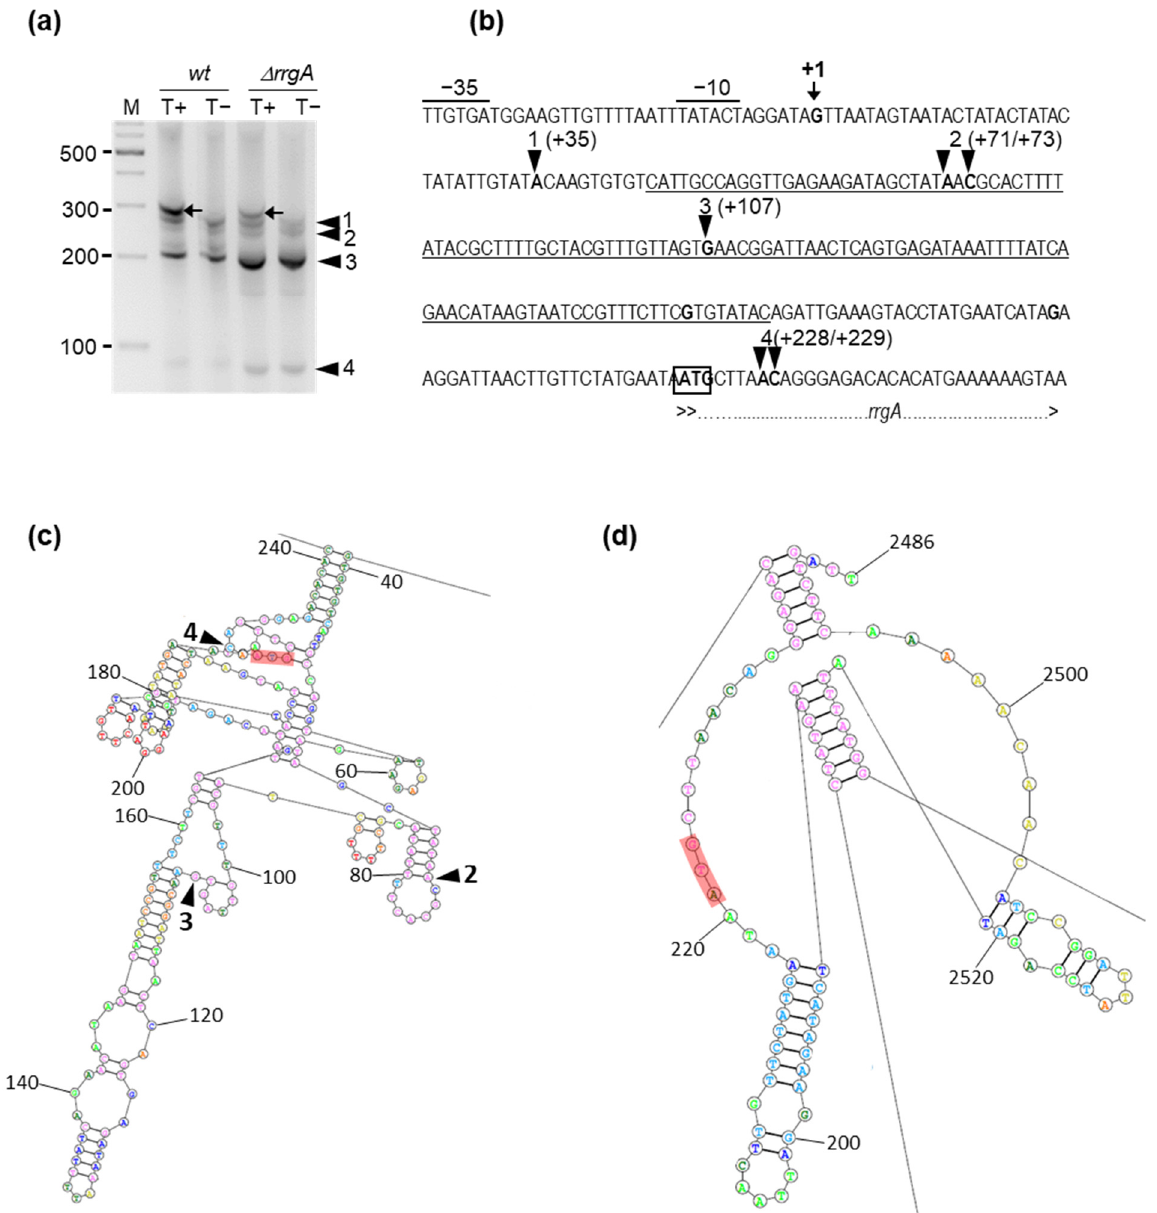
Figure 3. srn135 is generated upon processing of the rrgA transcript. ( a ) 5 ′ RACE mapping of the srn135 small RNA and the rrgA transcript. Reverse transcription was carried out on 7 μ g of total RNA extracted from the wild type and Δ rrgA mutant strains as described in Materials and Methods. PCR signals upon treatment with TAP (T+) or without treatment (T-) were separated in a 4% agarose gel. The RACE product that was present only in TAP-treated samples (black arrow) corresponded to the 5´-end of the full-length transcript, whereas RACE products 1, 2, 3, and 4 (arrowheads) present in TAP-treated and non-treated samples are likely to be processing fragments. ( b ) Sequence of the region comprising the 5 ′ UTR of rrgA mRNA and the beginning of the ORF. Transcriptional start site (highlighted with a black arrow) was identified as a G located 7 nt downstream of the − 10 box. The nucleotides corresponding to the 5 ′ -end of RACE products 1, 2, 3, and 4 (arrowheads), are highlighted in bold. The ATG of rrgA is delimited by an empty box and the beginning of the ORF is indicated as a dashed line. The putative − 35 and − 10 of the promoter are indicated and the nucleotide sequence of srn135 is underlined. Secondary structure prediction of the rrgA transcript before ( c ) and after processing at site 3 ( d ) was performed with RNAstructure web server tools. A diagram showing the predicted lowest free energy secondary structures obtained for the 5 ′ -end of full-length (left panel) and the processed rrgA mRNA (right panel). Numbering corresponds to nucleotide position from the +1 site. Main cleavage sites are labeled with arrowheads and the ATG codon of rrgA is labeled in red.